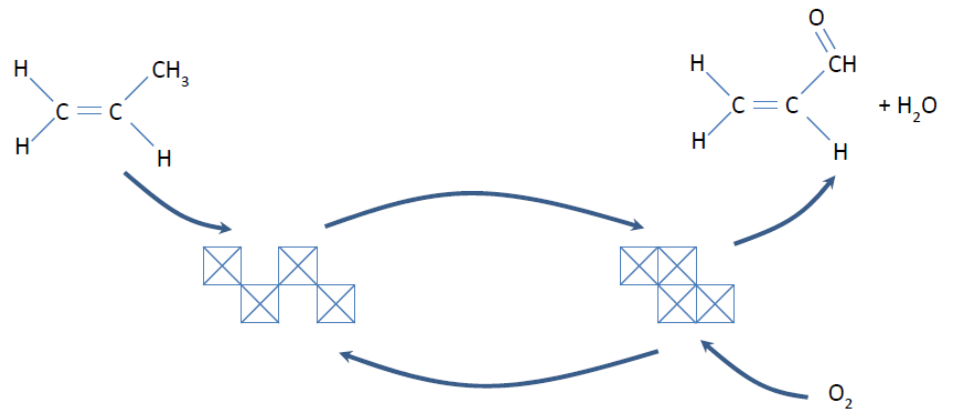
Figure 23. Schematic representation of the cyclic reduction/oxidation of twin pairs of MoO 6 octahedra between the corner and the edge-sharing arrangements (boxes represent MoO 6 octahedra with sharing of oxygen atoms at corners for MoO 3 or edges for MoO 2 ). The figure is not completely accurate, because it cannot take into account the fact that the arrangements are not perpendicular to the main axes of the lattice. Adapted from